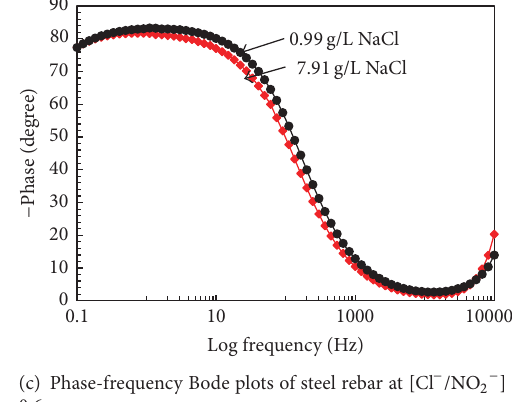
(a) Nyquist plots of steel rebar at [Cl − / NO 2− ] = 0.6 (b) Impedance-frequency Bode plots of steel rebar at [Cl − / NO 2− ] = 0.6